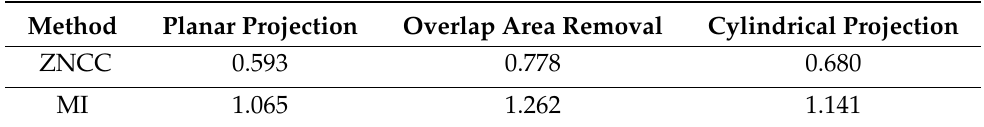
Table 4. Evaluation results of the proposed presentation methods. ZNCC: Zero-mean Normalized Cross-Correlation; MI: Mutual Information.